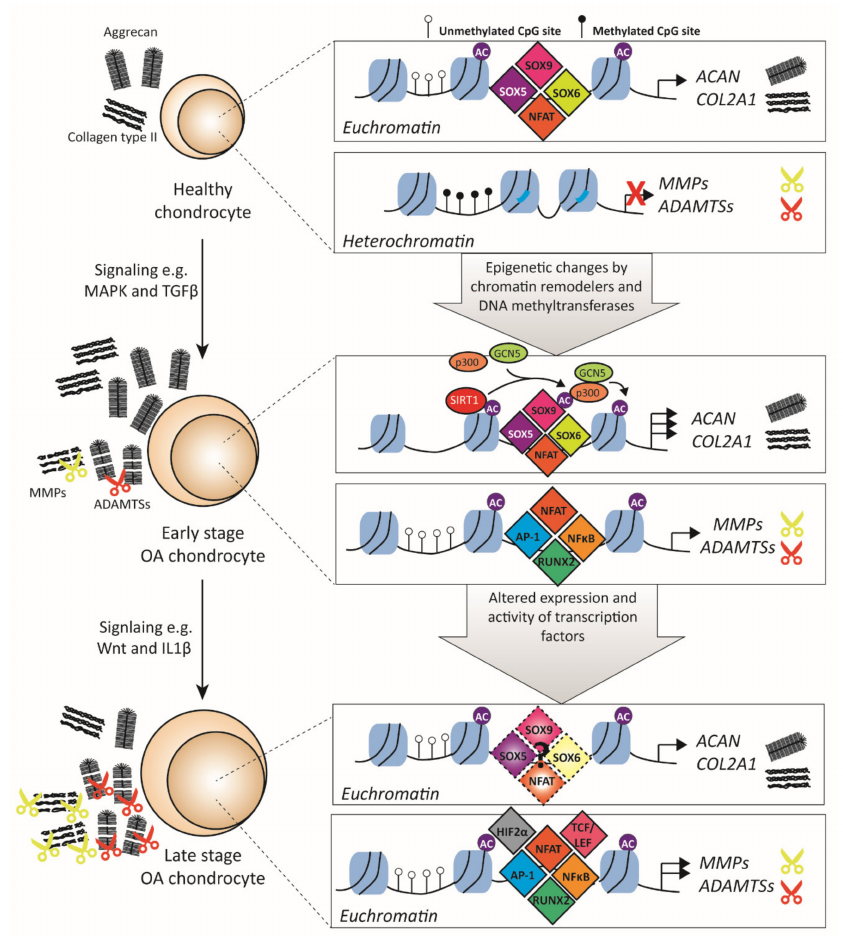
Figure 2. Transcriptionfactorsinvolvedinextracellularmatrix(ECM)metabolism.